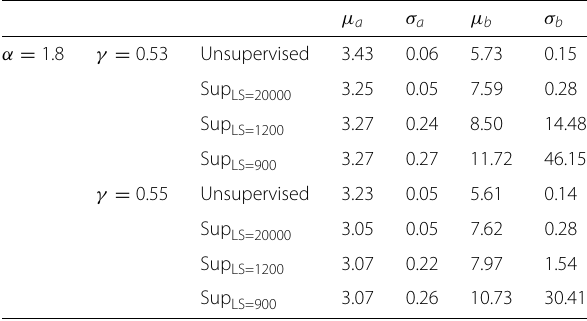
Table 1 Parameter